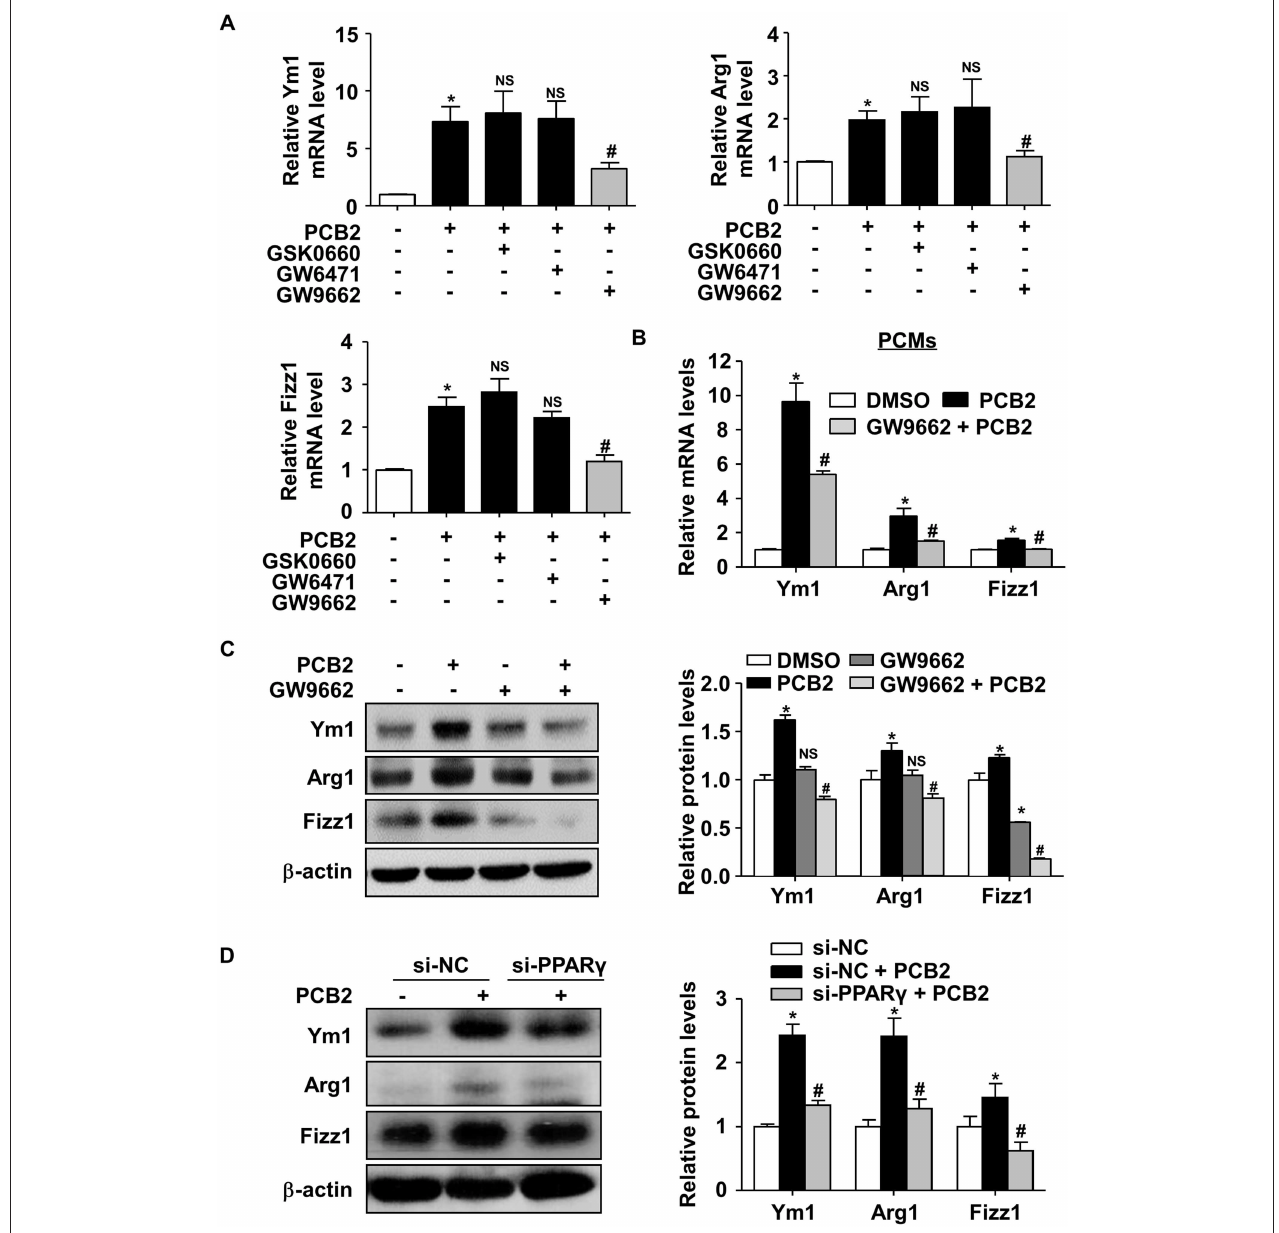
FIGURE 3 | PCB2 promoted macrophage M2 polarization via PPAR γ activation. (A) RAW264.7 cells were pre-treated with GSK0660 (2 µ M), GW6471 (2 µ M), or GW9662 (5 µ M) for 1h, then exposed to PCB2 (10 µ M) for 24h. Total RNA was extracted and subjected to qRT-PCR for the assessments of Ym1, Arg1, and Fizz1 mRNA levels. (B) PCMs were pre-treated with GW9662 (5 µ M) for 1h, then exposed to PCB2 (10 µ M) for 24h. Expression of Ym1, Arg1, and Fizz1 were measured by qRT-PCR. (C) Ym1, Arg1, and Fizz1 protein levels were measured by using western blotting. (D) RAW264.7 cells were transfected with PPAR γ siRNA or NC siRNA for 24h and then treated with PCB2 (10 µ M) for another 24h. Ym1, Arg1, and Fizz1 protein levels were detected by using western blotting. Data were shown as mean ± SEM, n = 3–5, * P < 0.05 vs. control; # P < 0.05 vs. PCB2 or NC siRNA treated with PCB2; NS, not significant.